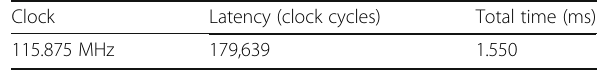
Table 4 First approach OCR algorithm performance estimates